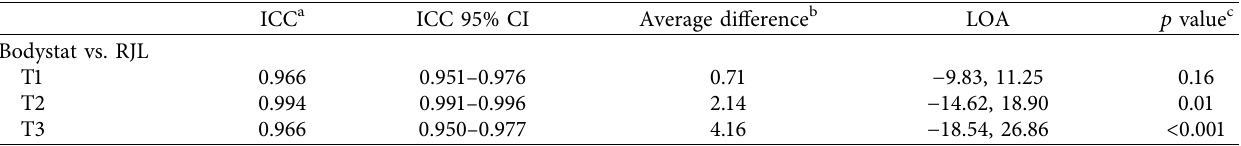
Table 4: Reproducibility in the method comparison of Bodystat vs. RJL for measurement of impedance ( Ω ).